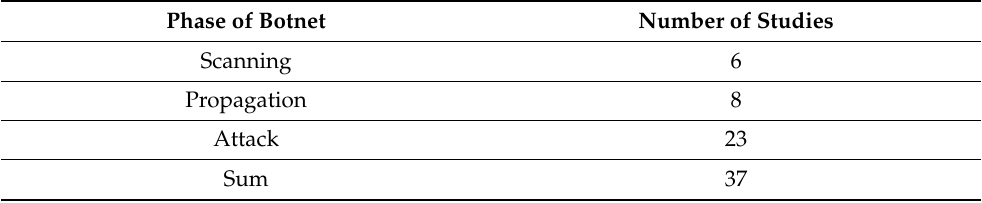
Table 9. Numbers of studies focusing on the different phases of IoT botnet